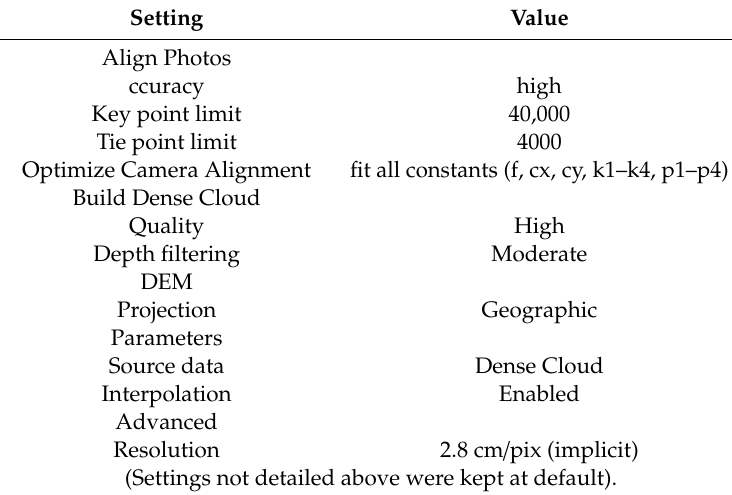
Table 3. Agisoft Metashape software settings used for